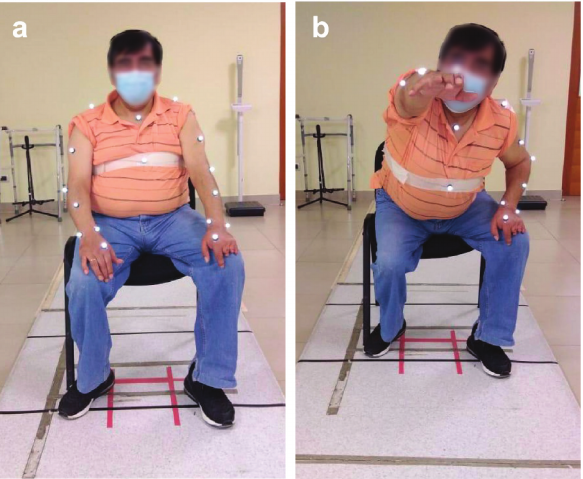
Figure 3. Maximum Forward Reach Test sequence. ( a ) Initial position and ( b ) Final position.